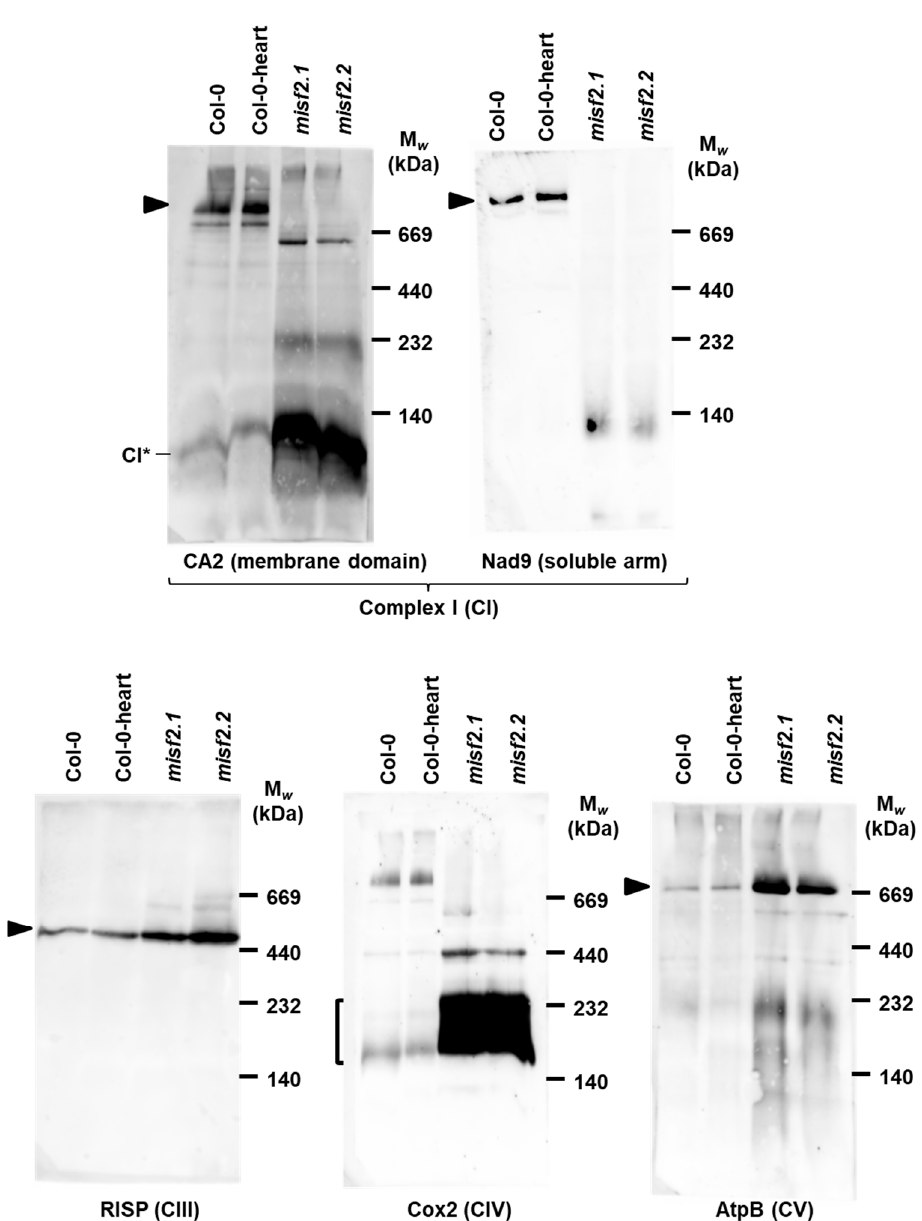
Figure 7. Holo-complex I is below detectable levels in misf2 mutants. Blue native (BN)-PAGE analysis of crude organellar fractions was performed as described by [79]. Aliquots, equivalent to 40 mg of crude organellar membrane extracts, obtained from wild-type and misf2 plants, were solubilized with digitonin and resolved by BN-PAGE. For immunodetection, the proteins were transferred onto PVDF membranes and probed with the antibodies indicated below each blot (Table S2). Arrows point toward native complexes I (~1000 kDa), CIII dimer (III 2 , ~500 kDa), CIV (about 200 and 220 kDa forms), and CV (~660 kDa) [69]. CI* indicates the ~85 kDa sub-CI assembly intermediate